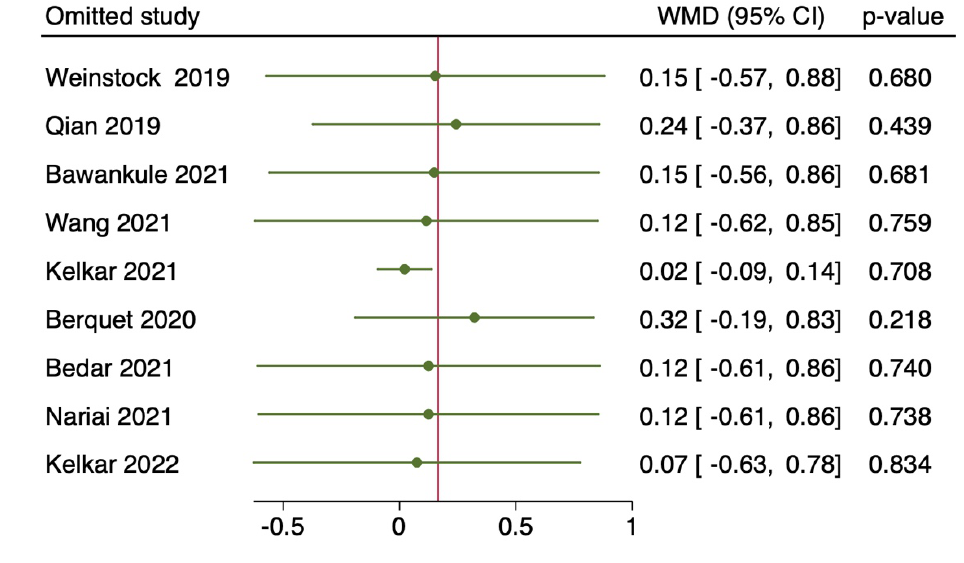
Figure 4. Leave-one-out method: of mean surgical duration time: the horizontal lines and the circles indicate the weighted mean difference and the 95% confidence intervals applying the leave-one-out method. [4,5,7–9,11–14]